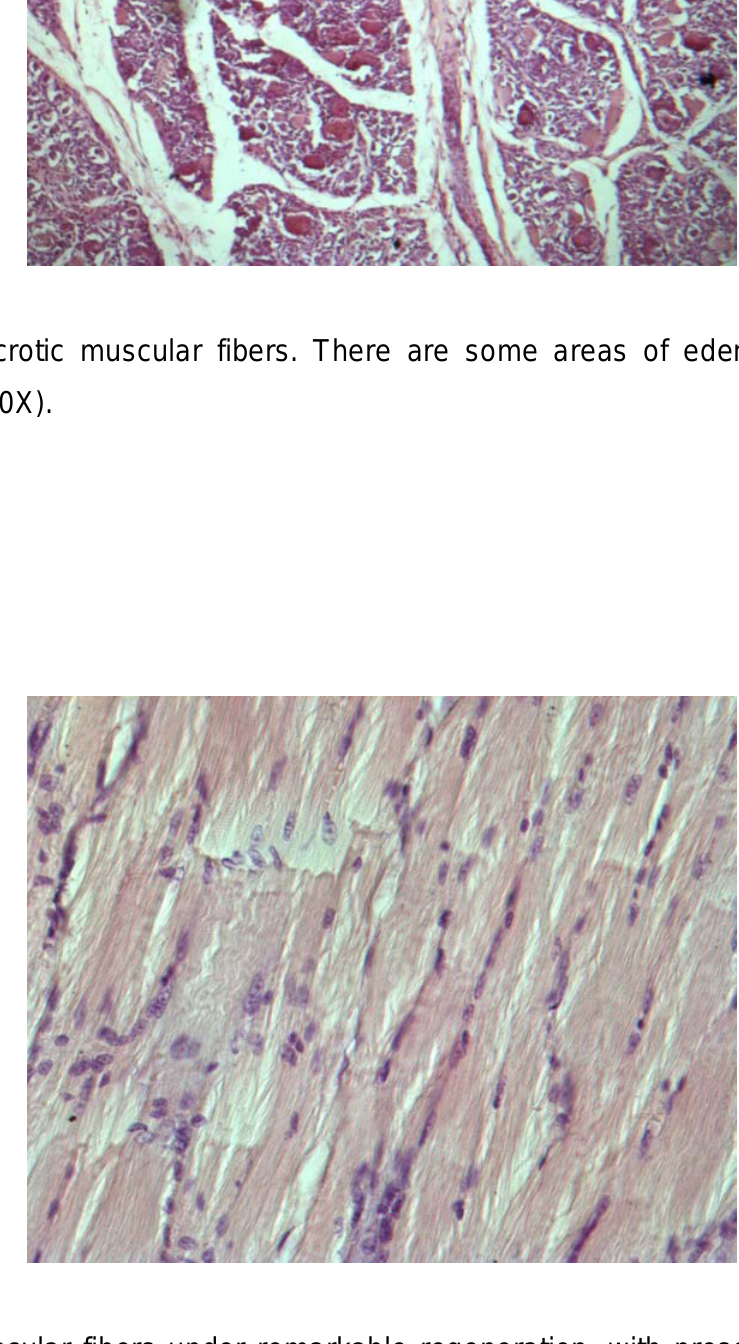
Figure 3. Muscular fibers under remarkable regeneration, with presence of satellite cells, in one animal from Group III (HE,